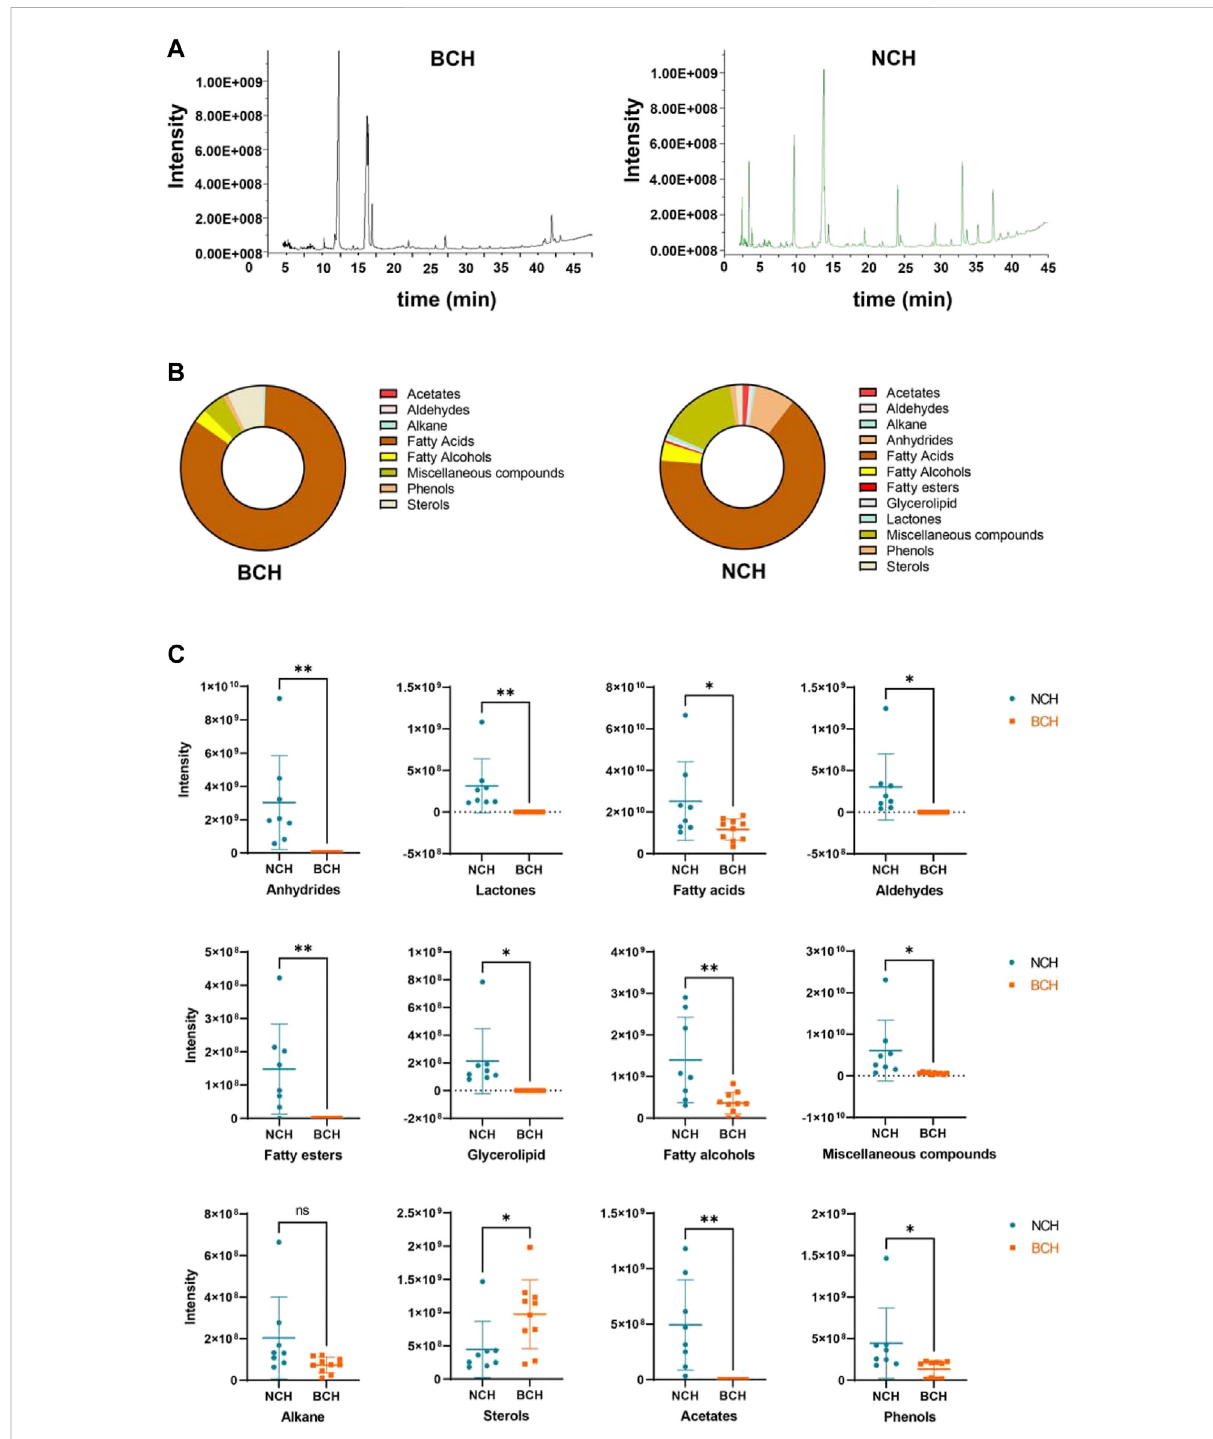
Chemical characterization of SFEs from BCH and NCH. (A) The typical total ion chromatograms (TIC) of the representative samples of BCH (BCH001)andNCH(NCH001)byGC-MSanalysis; (B) thecompositionalfeaturesinSFEsfromBCHandNCH;and (C) thecharacteristicdistributionof differenttypesofcomponentsinSFEsfromBCHandNCH.DataarepresentedasMean±S.D.( n =10forBCHand n =8forNCH).* p < 0.05and** p < 0.01 by unpaired t